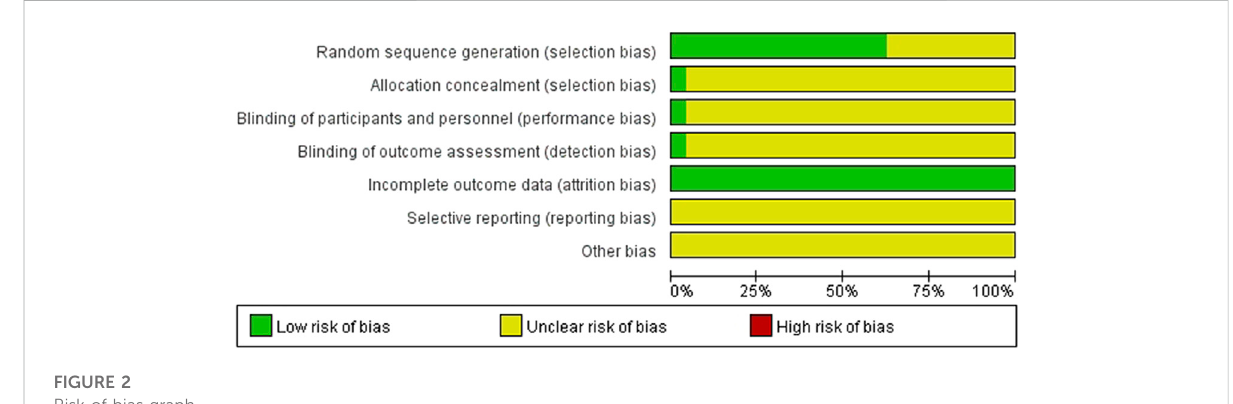
FIGURE 2 Risk of bias